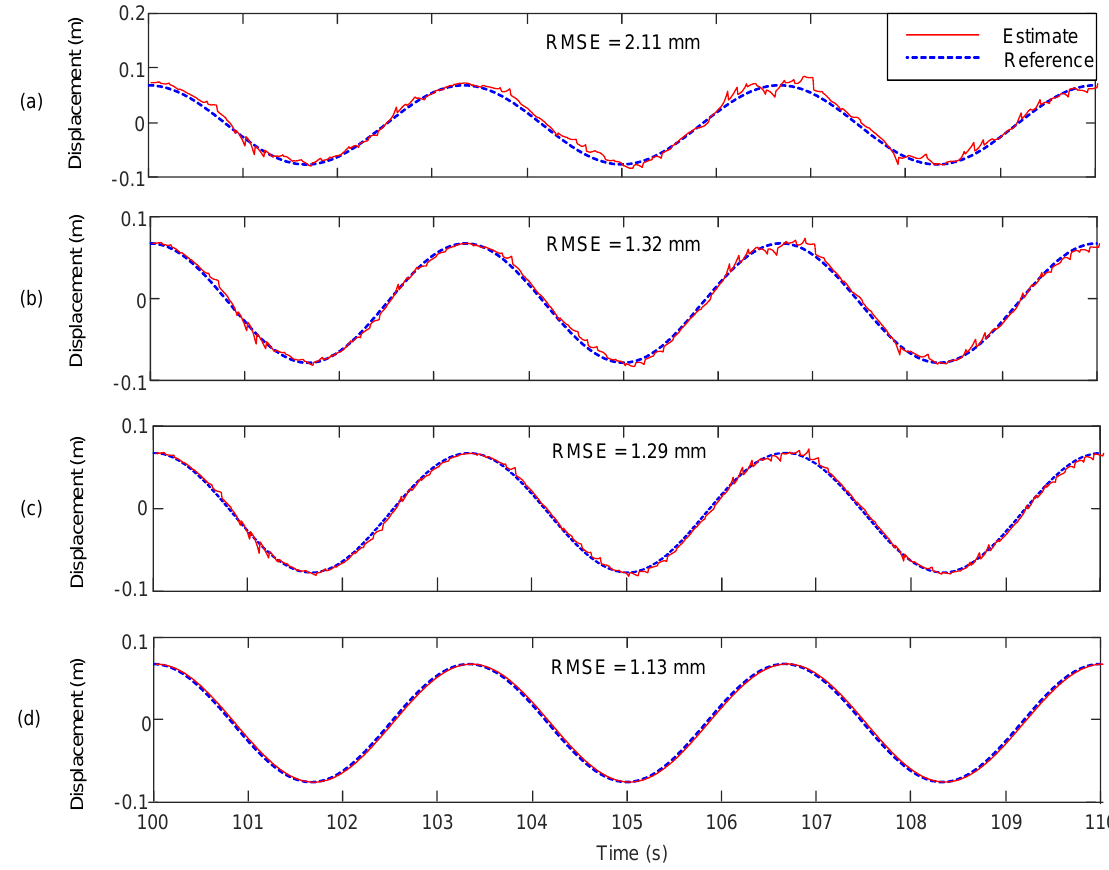
Figure 10. Comparison of the proposed measurement system with other data fusion techniques (for 0.3 Hz sinusoidal vibration input in Case 1: ( a ) Smyth and Wu [24] with RTS smoothing; ( b ) Kim et al. [25] with forward-backward smoothing; ( c ) Kim et al. [27] and; ( d ) the proposed system.